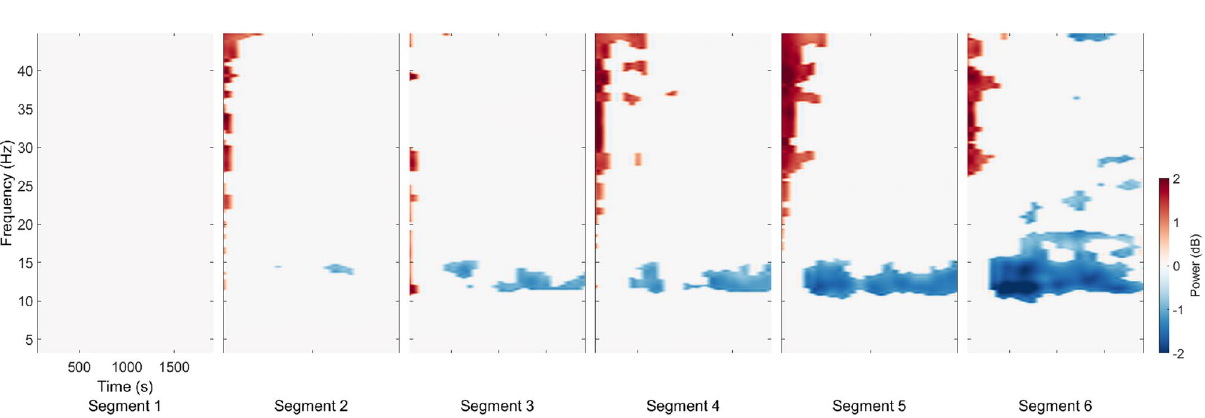
Figure 4. The permutation test (n=2000, FDR-correlated) of the RSC ERSP for 6 segments in comparison to segment